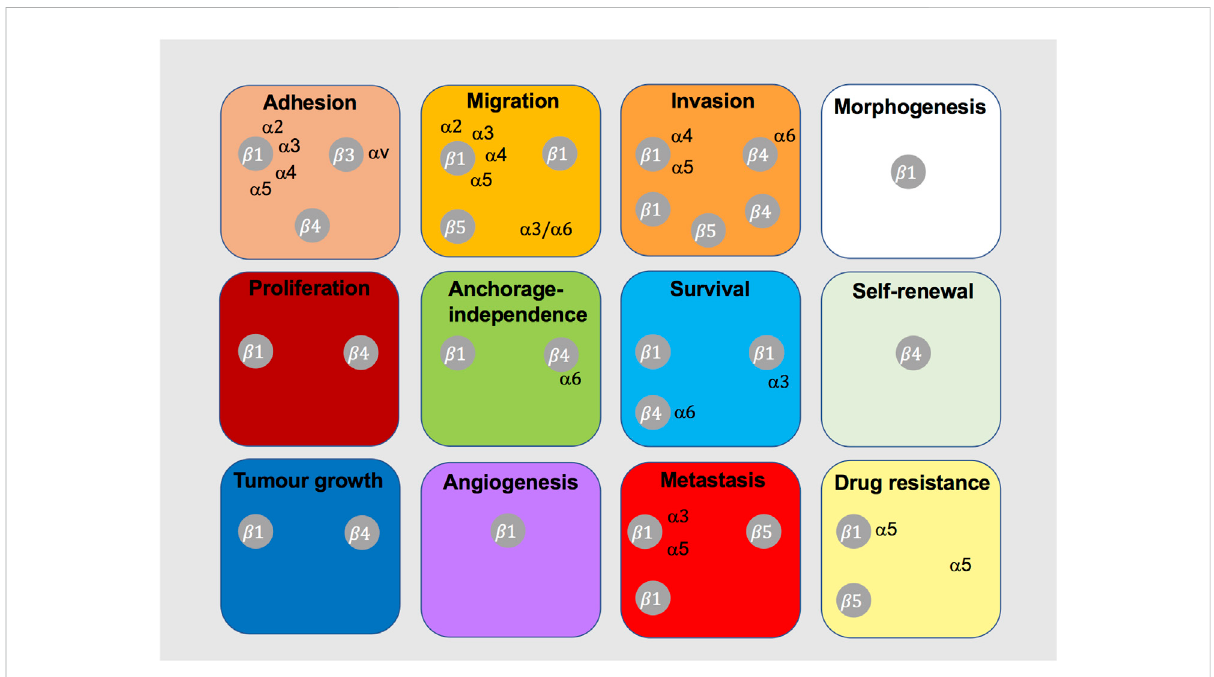
FIGURE 8 Integrinsshowntocooperatewithc-Metintumorigeniccellbehaviour.Thisdiagramindicatestheintegrinsthathavebeenshowntocooperate with c-Met for the indicated cancer-related cell function or